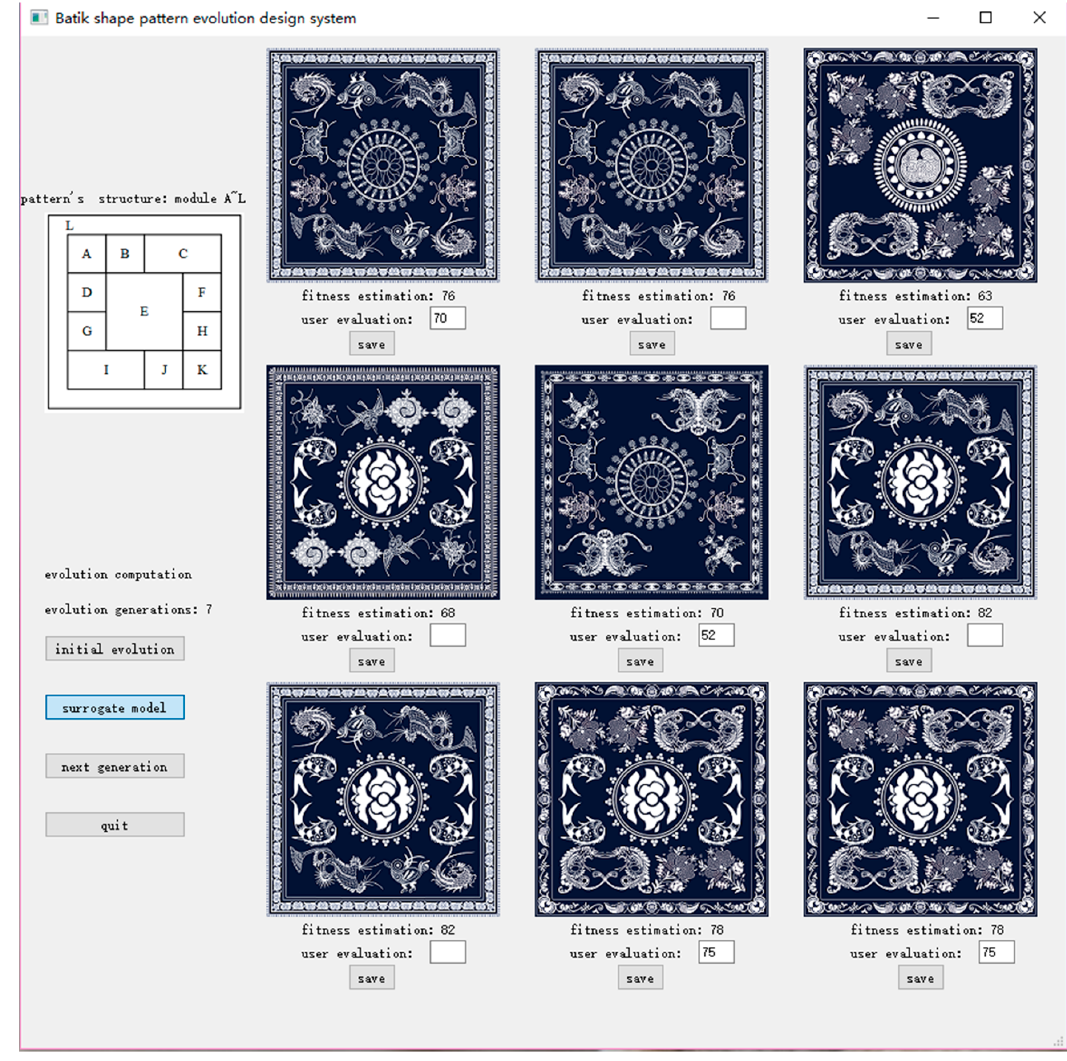
Figure 5. The system interface.